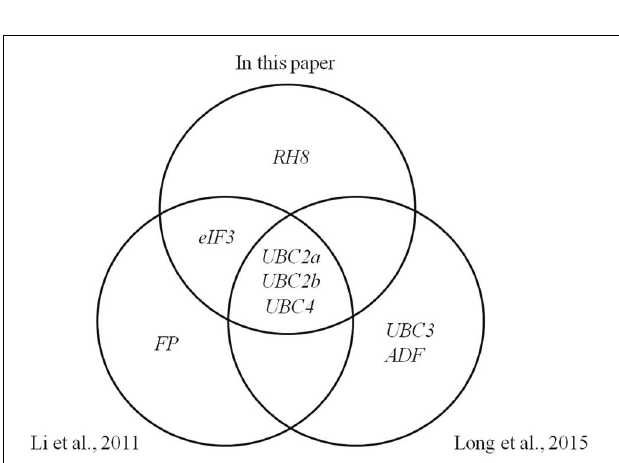
FIGURE 5 | Comparing suitable reference genes screened here with previous studies on rubber tree. The top five best references of each experimental group were analyzed